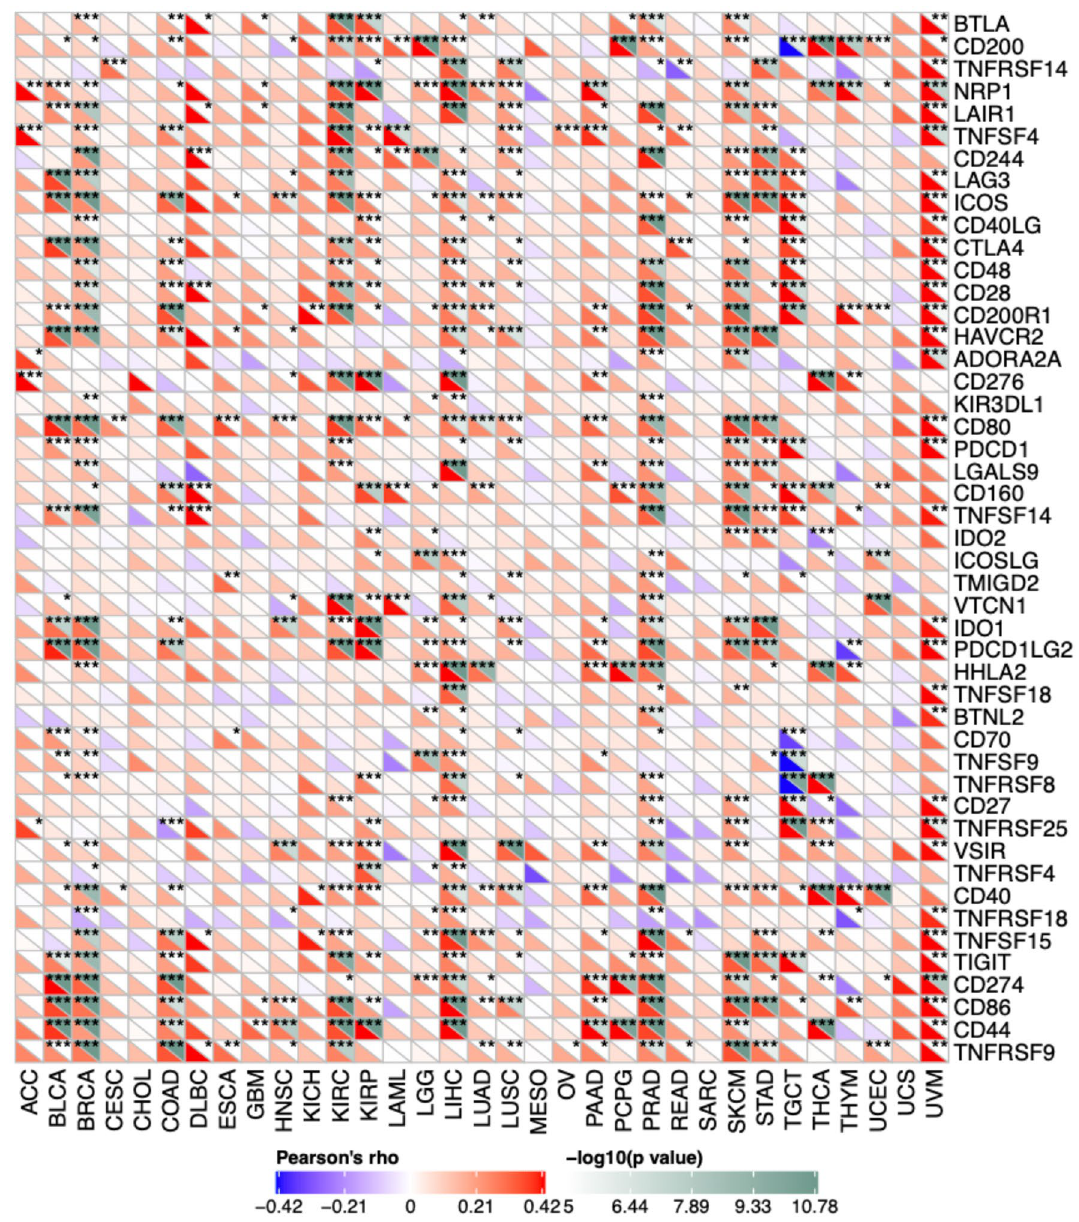
Figure 6. The pearson analysis between CD47 expression and immune checkpoint genes in 33 cancer types. The expression of CD47 was positively correlated with immune checkpoint markers in BLCA, DLBC, KICH, KIRC, LUAD, LUSC, PAAD, PCPG, SKCM, STAD, UCEC and UVM. and Increased CD47 was positively correlated with BTLA, ICOS, CD40LG, CTLA4, CD48, CD28, CD200R1, HAVCR2, CD80, PDCD1(PD-1), CD160, IDO1, HHLA2, CD40, TNFSF15, TIGIT, CD274, CD86, CD44, TNFRSF9. *Indicates P value < 0.05; ** indicates P value < 0.01; *** indicates P value <